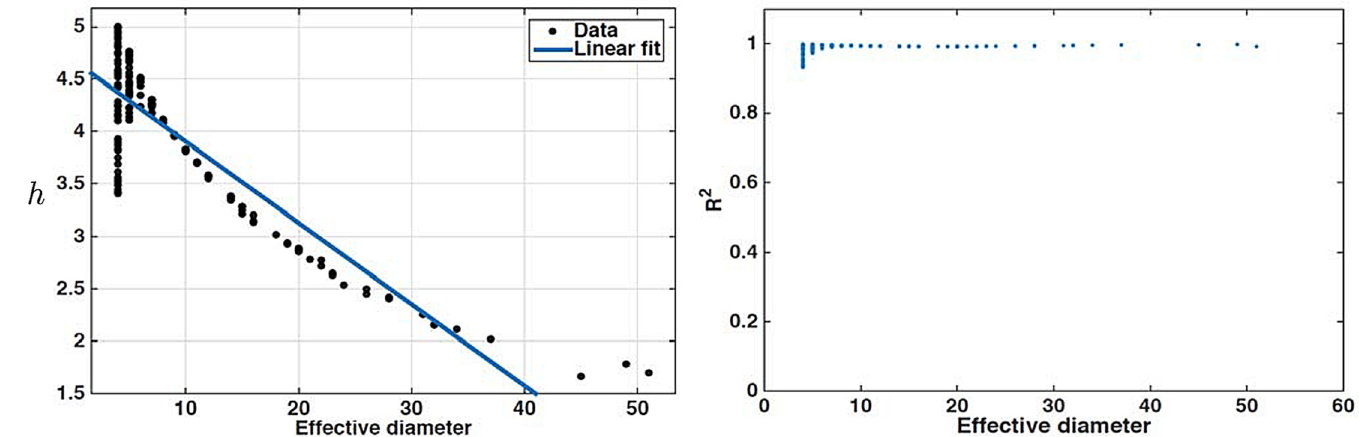
Fig 4. power-hop exponent for Kronecker networks. The networks generated with the Kronecker network model exhibit effective diameters that span a large range. The linear fit obtained for the h of every network exhibits large R 2 values even for larger δ